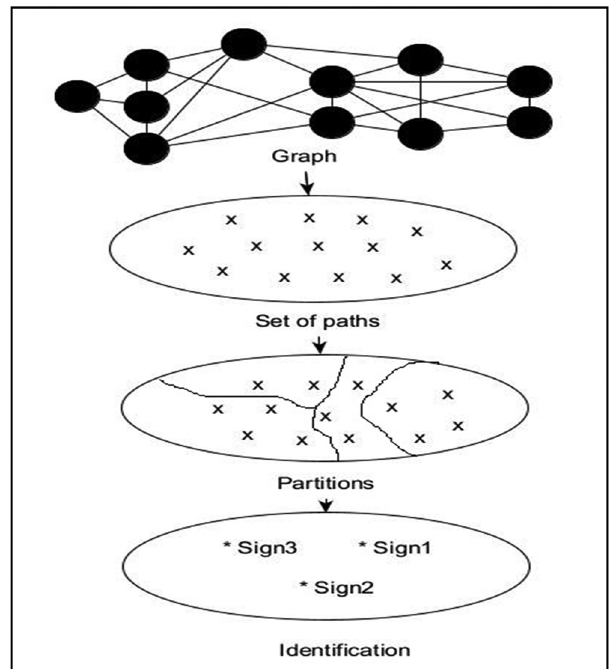
Figure 6: Construction of the quotient